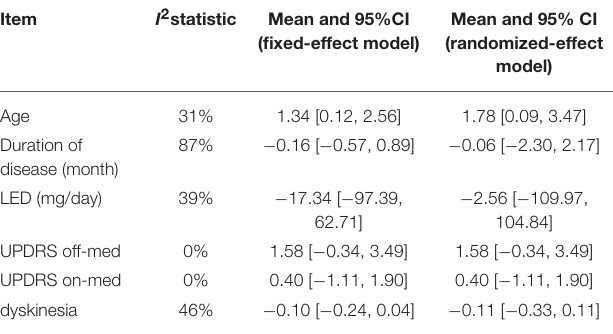
TABLE 3 | Meta-analysis results of Profile comparison for STN DBS vs. GPi DBS.